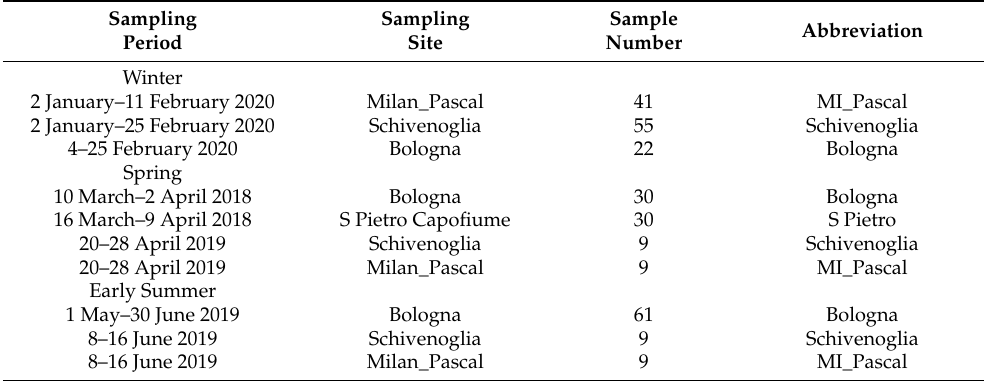
Table 3. Overview of samples analyzed in this study: sampling period, site location and number of PM 2.5 collected filters for each sampling